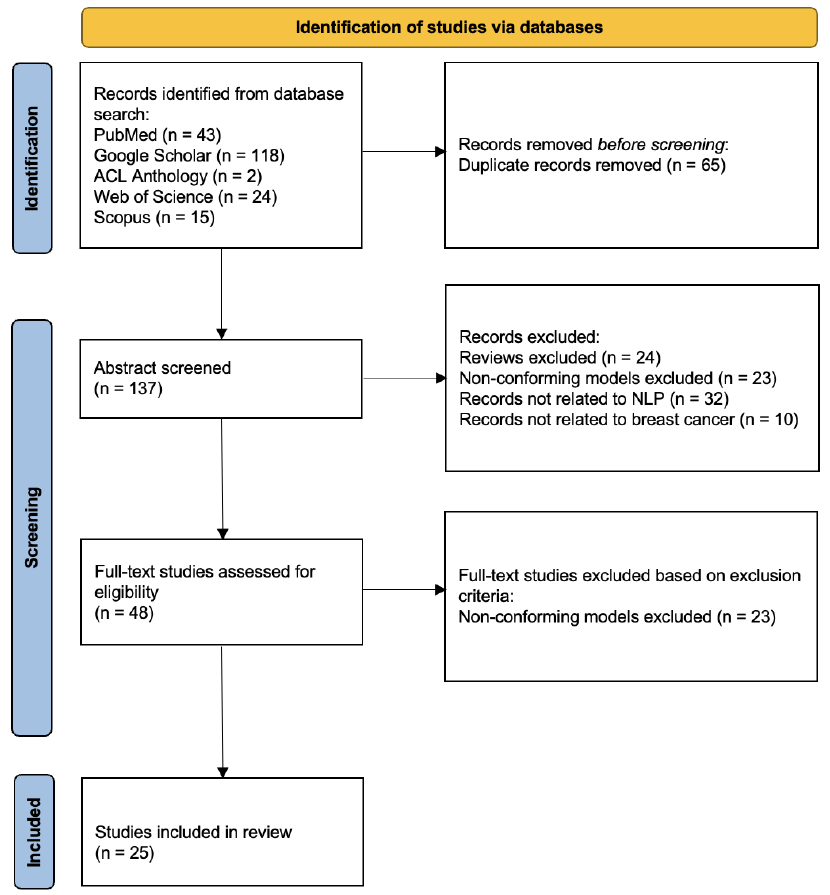
Figure 2. PRISMA diagram for study selection.